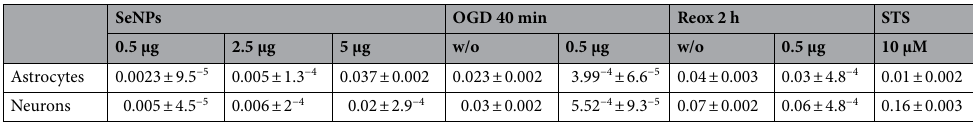
(Fig. 3D, red curve; Table 2), compared with astrocytes—0.01 ± 0.002 (Fig. 3D, black curve; Table 2). To analyze the participation of apoptosis marker genes in the activation of caspase-3, we selected two con- centrations of SeNPs—0.5 and 5 µg/ml. Both high (5 µg/ml) and low (0.5 µg/ml) concentrations of SeNPs, added for 24 h to the cells, lead to an increase in the expression of genes encoding anti-apoptotic proteins—Bcl-2, Bcl-xL, and inflammatory Socs3. But the expression of the pro-apoptotic gene, Bax, on the contrary, is sup- pressed (Fig. 4A). After incubation of cells with 0.5 μg/ml, there is an increase in the expression of genes Bcl-2, Bcl-xL, Socs3 by 73%, 2.9 times, 71% and 4.9 times, compared with the control (Fig. 4A, dashed line, taken for 1), and the expression of Bax and Stat3 is suppressed by 61% and 97%, respectively. At the same time, 5 µg/ml SeNPs increase the expression of Bcl-2, Bcl-xL, Stat3 and Socs3 by 3.4, 5.87, 4.11, 2.3 and 6.2 times, respectively (Fig. 4A, red bars). The expression level of the gene encoding Nrf 2 also tends to increase after incubation with both concentrations of SeNPs. Incubation of cells with SeNPs alters the level of selenoprotein expression (Fig. 4B). A low concentration of SeNPs (0.5 µg/ml) leads after 24 h of incubation to a trend towards a decrease in the genes SelK (by 47%) and SelT (by 98%), while the expression of SelN and SelP does not significantly decrease (Fig. 4B, black bars). A high concentration of SeNPs (5 µg/ml), on the contrary, causes an increase in the expression of SelK, SelN, SelT, SelP by 3.82, 4.21, 6.4 and 2.37 times, respectively (Fig. 4B, red bars). Thus, high concentrations of SeNPs 2.5–5 µg/ml lead to the induction of apoptosis through the activation of caspase-3 with a higher rate of increase in the process in astrocytes as compared to neurons. Both low and high concentrations of SeNPs cause an increase in the expression of genes encoding anti-apoptotic proteins and a decrease in the level of pro-apoptotic (Bax), which indicates the activation of apoptosis and neuroprotective signaling cascade along with the caspase-signaling pathway. However, the level of genes expression encoding selenoproteins after incubation with 0.5 µg/ml SeNPs decreases, and at 5 µg/ml, on the contrary, increases, which may indicate the suppression of endoplasmic reticulum stress, in the case of low doses, and activation of this process at using high doses.